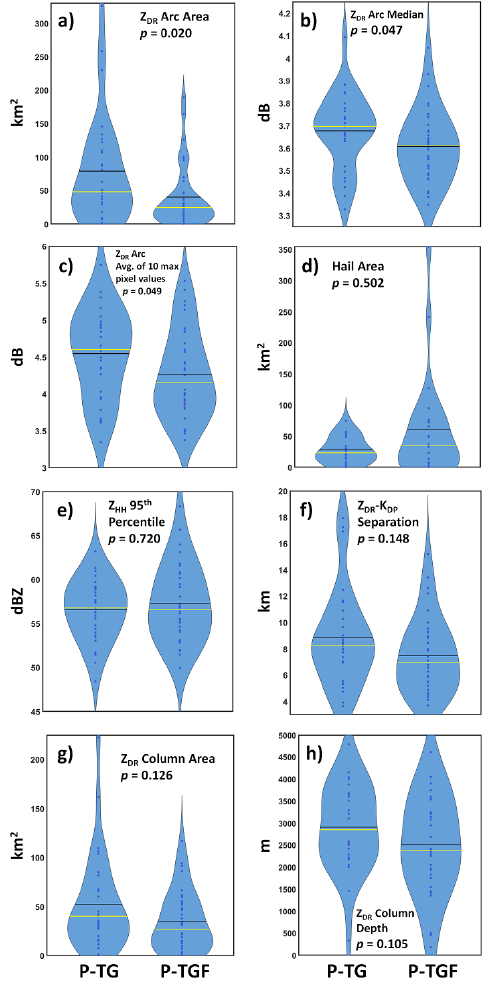
Figure 2. Violin plots of some common radar metrics for pre-tornadogenesis (P-TG) and pre-TGF (P-TGF) storms: ( a ) area of the Z DR arc (km 2 ), ( b ) median pixel value within the Z DR arc (dB), ( c ) average of the 10 maximum pixel values within the Z DR arc (dB), ( d ) base-scan area of polarimetrically-inferred hail (km 2 ), ( e ) average Z HH value of pixels in the storm core exceeding the 95th percentile of Z HH (dBZ), ( f ) separation distance between Z DR arc and K DP foot centroids (km), ( g ) area of the 1 dB Z DR column above the ambient 0 °C level (km 2 ), and ( h ) maximum Z DR column depth (m). In each violin, the yellow line is the median and the black line is the mean, and the WMW p -value for each comparison is included in each panel. Dots within the violins are the raw values, one for each storm that contributed.